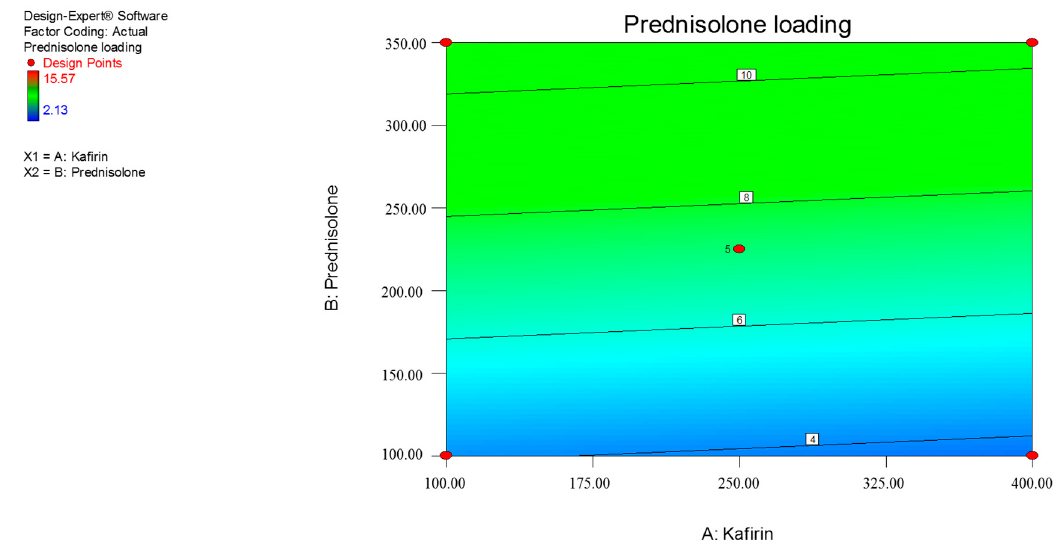
Figure 1 . Contour plot showing the effects of kafirin and prednisolone quantities (mg) on ( Y 1 ) prednisolone loading (%). The numbers in the small squares refer to the response value.